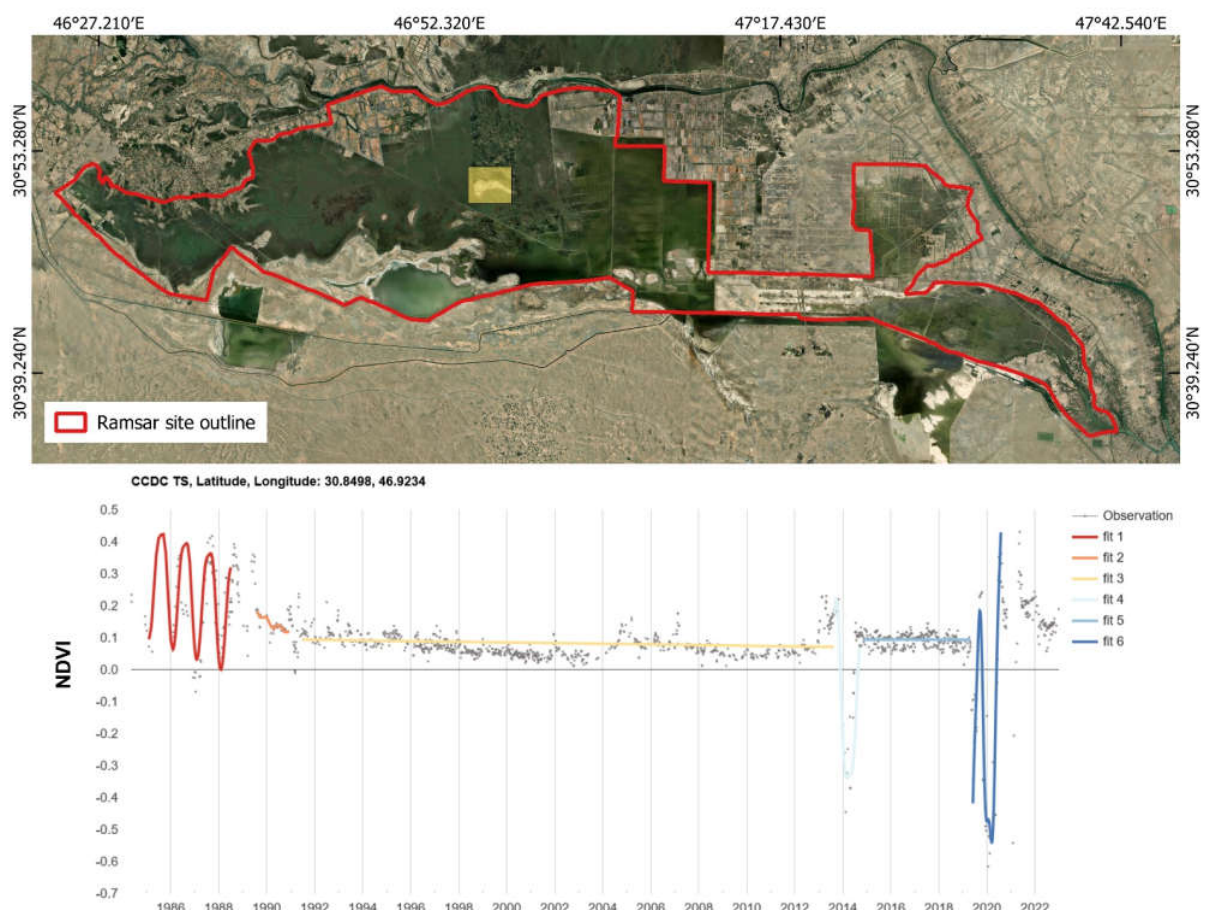
Figure 8. Example of the normalized difference vegetation index (NDVI) time series for a pixel (yellow rectangle) in the Iraqi Hammar Marsh (Ramsar site ID 2242) derived from the Landsat archive from 1984 to 2022 obtained using the CCDC algorithm developed by [197] in Google Earth Engine. Grey dots indicate Landsat observations available in the pixel and used for harmonic regression of the time series. The fits in the colored lines indicate time segments detected by the CCDC algorithm: a change in color indicates a change in land cover/land use.